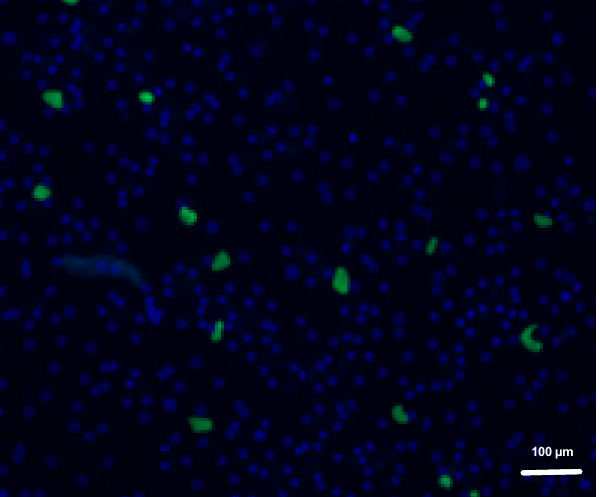
Figure A3. Representative image of P. berghei liver stage parasites in simian hepatocytes after two post-sporozoite infections visualized with DAPI (blue), GFP expression and immunofluorescent detection (green). Scale bars indicate 100 µm.